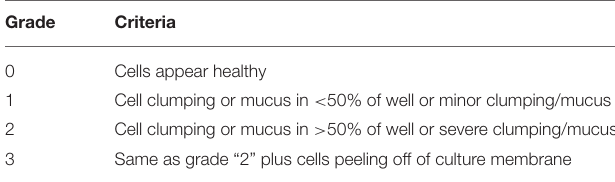
TABLE 1 | Grading scale for cytopathic effect. Grade